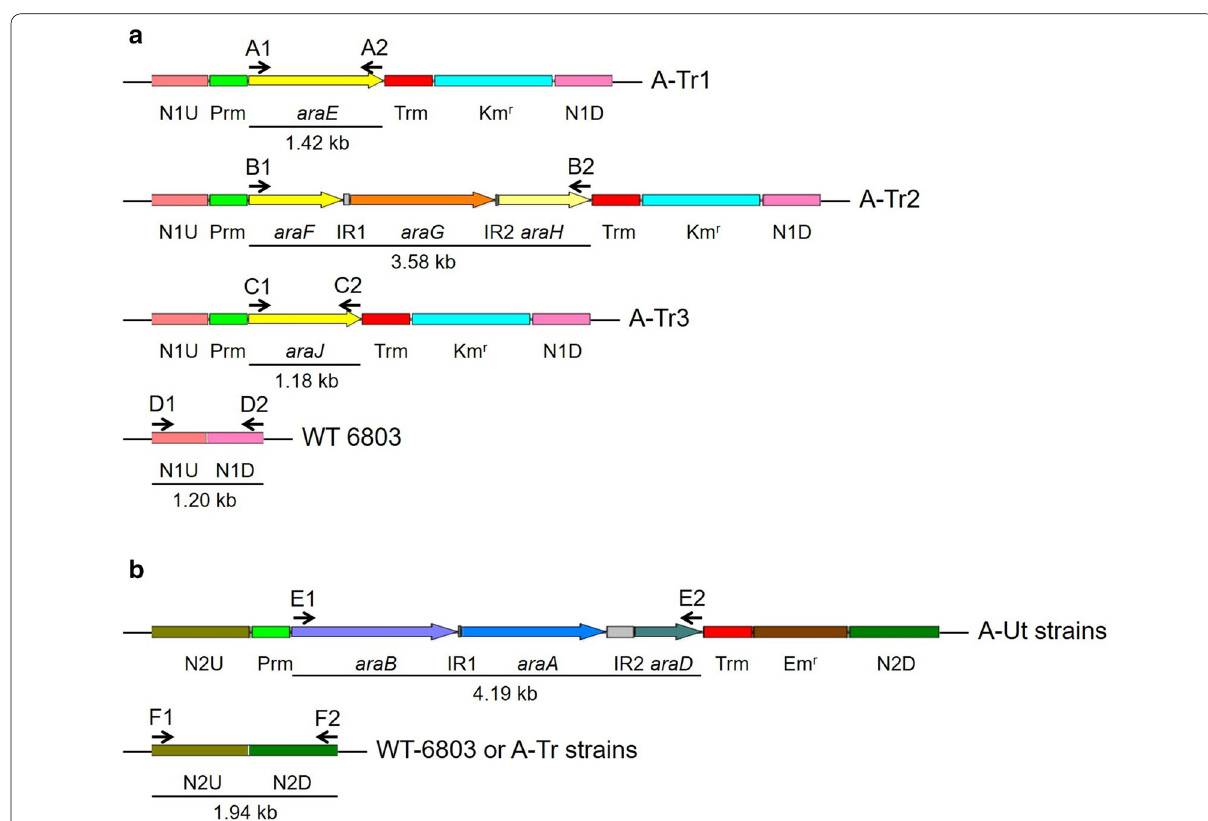
Fig. 2 Transformation of Synechocystis strains. All transgenes used in the study were expressed under the control of the psbA2 promoter (Prm) and 5ST1T2 terminator (Trm). Intergenic regions (IR) present between individual genes in the gene sets are represented as grey boxes. Numbered letters and arrows represent the primer pairs, and the direction of the amplifications, respectively. a Genes encoding the arabinose transporters were inserted into neutral site 1 in the Synechocystis WT genome using upstream (N1UP) and downstream (N1DW) regions for homologous recombination. The kanamycin resistance cassette (Km r ) was used for the selection and segregation of the transformants. b The araBAD gene set, encoding enzymes that funnel arabinose into the pentose phosphate pathway, was inserted into neutral site 2 in the genomes of Synechocystis strains carrying one of the three arabinose transporter genes and the WT strain using upstream (N2UP) and downstream (N2DW) regions for homologous recombination. The erythromycin resistance cassette (Em r ) was used for the selection and segregation of the